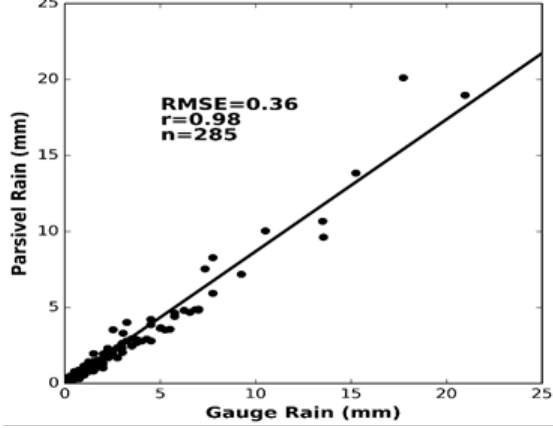
Figure 2. Comparison of accumulate rainfall (mm) between Parsivel2 and gauge rain in which both are separate at 10 m. Root Mean Square Error (RMSE) is 0.36, correlation of 0.98 and events number (n) comparison is